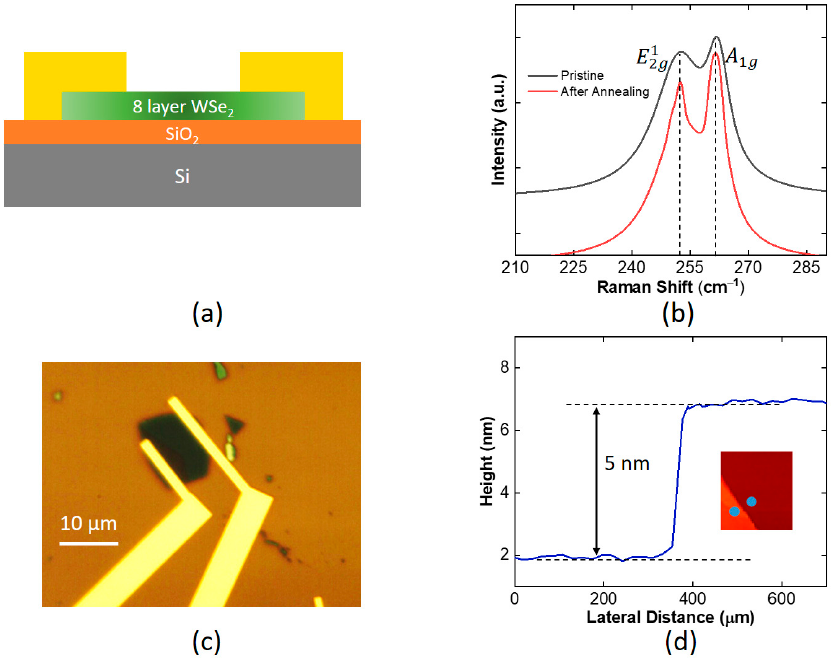
Figure 1. ( a ) Schematic of the WSe 2 device. ( b ) Raman spectrum of the WSe 2 before and after annealing. ( c ) Optical microscope image of the device. ( d ) AFM image and height profile of the WSe 2 layer.